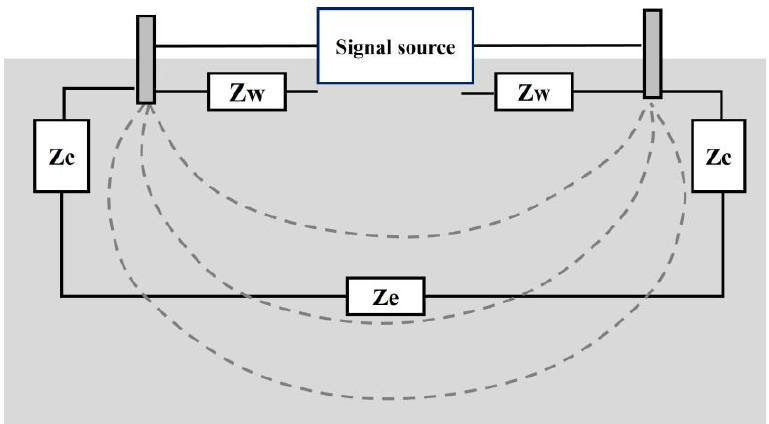
Figure 1. Strong penetration technology based on ground electrode current injection.